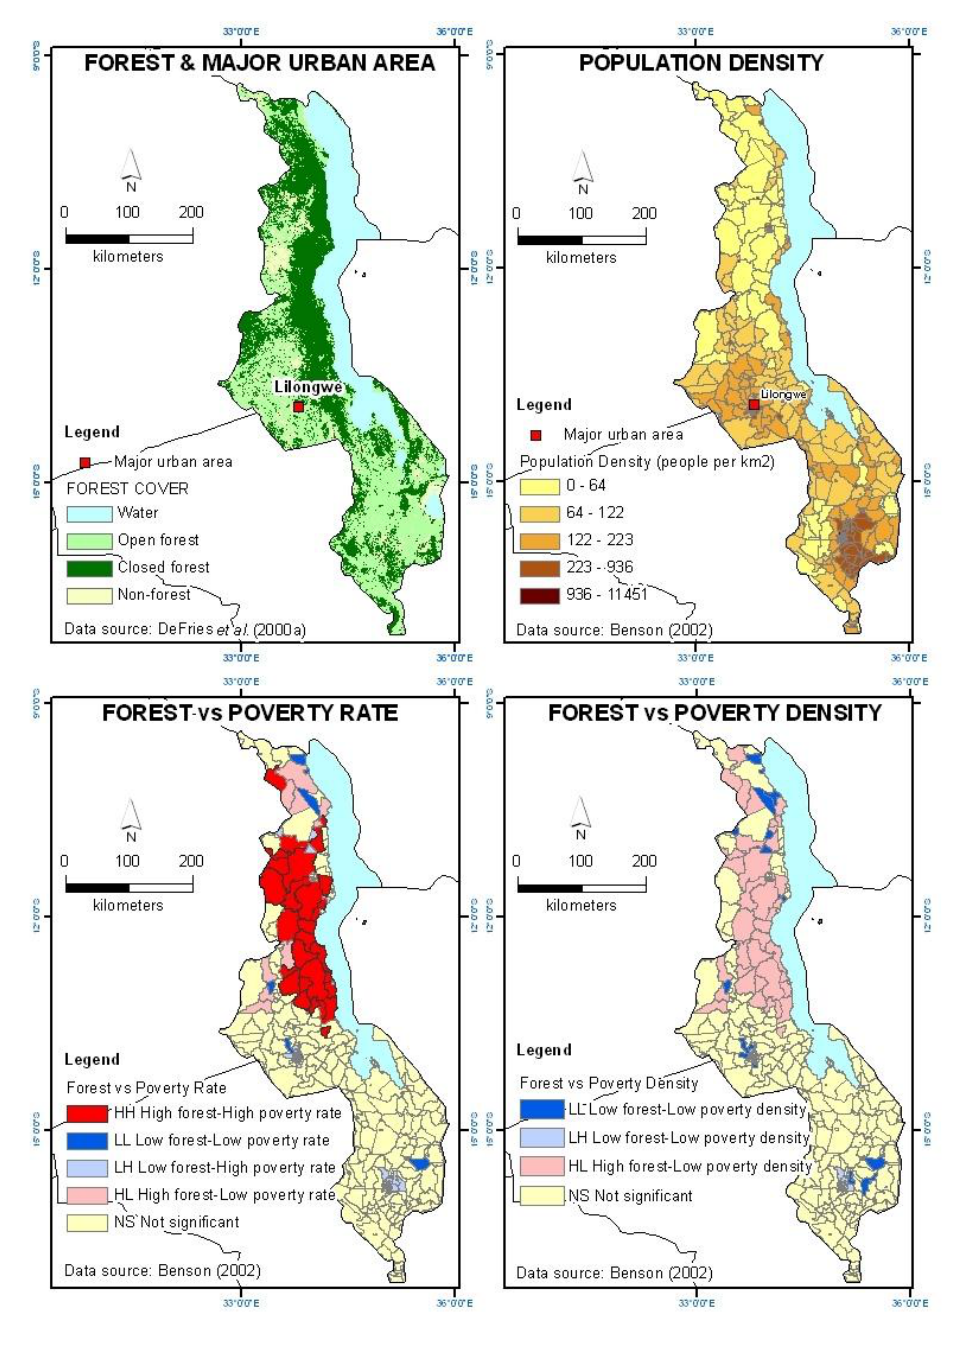
Fig. 3. Malawi. Maps of forest and major urban areas, population density, local indicators of spatial association (LISA) analysis of forest cover by poverty rate, and LISA analysis of forest cover by poverty